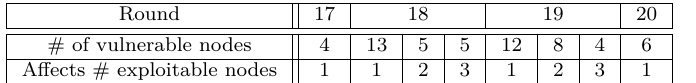
Table 14: Results for PRIDE